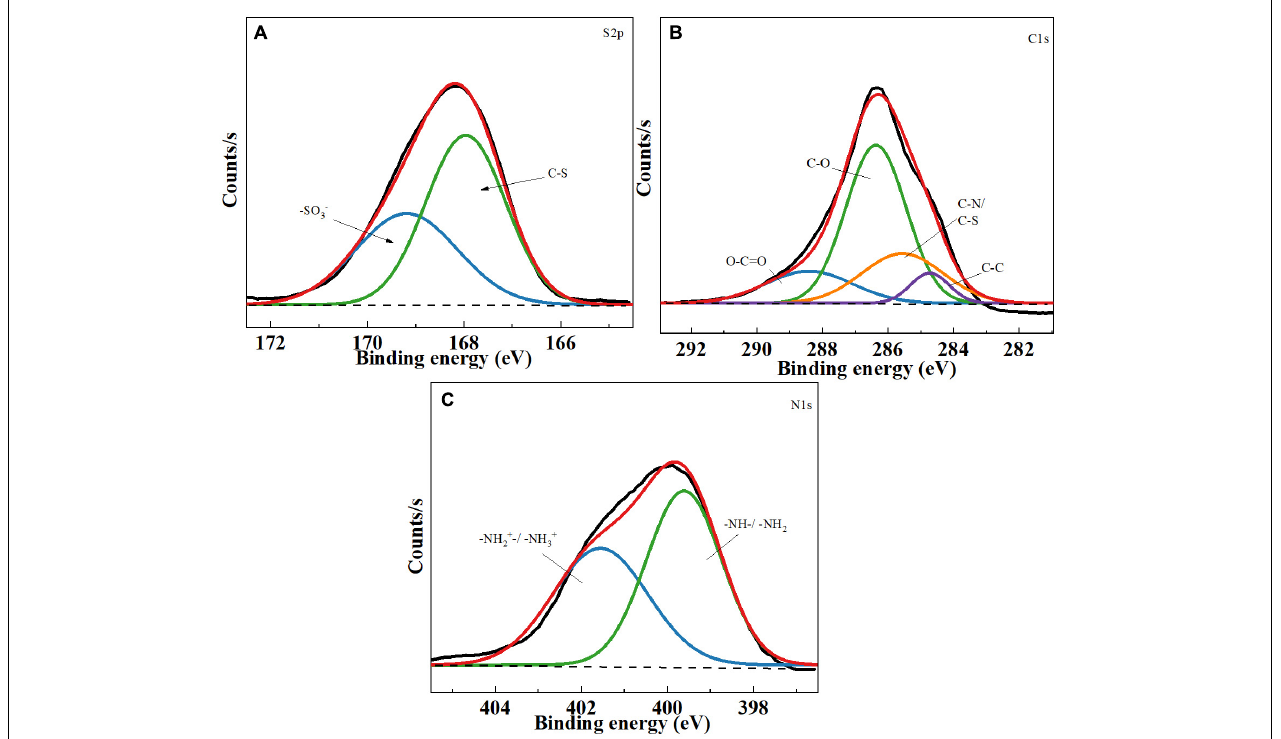
FIGURE 2 | X-ray photoelectron spectroscopy (XPS) spectra of TOCNF-PABS. (A) S2p core-level spectra of TOCNF-PABS; (B) C1s core-level spectra of TOCNF-PABS; (C) N1s core-level spectra of